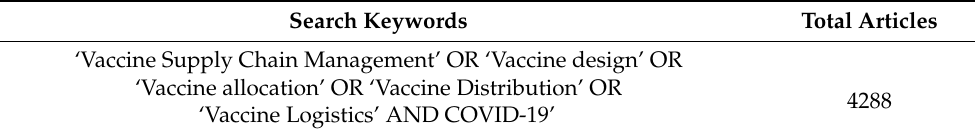
Table 3. Initial results with reference to COVID-19 search.